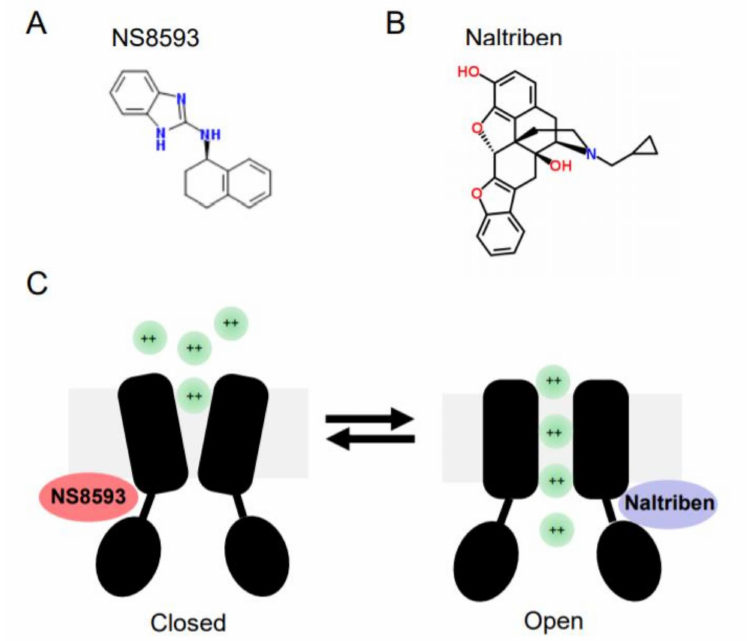
Figure 2. Chemical structures and mode of action of NS8593 and naltriben on the TRPM7 channel. ( A ) NS8593 chemical structure. ( B ) Naltriben chemical structure. ( C )The TRPM7 channel is depicted in the closed and open states. NS8593 acts as negative gating modulator of the channel, whereas naltiben triggers opening of TRPM7 and influx of divalent cations (green balls) into the